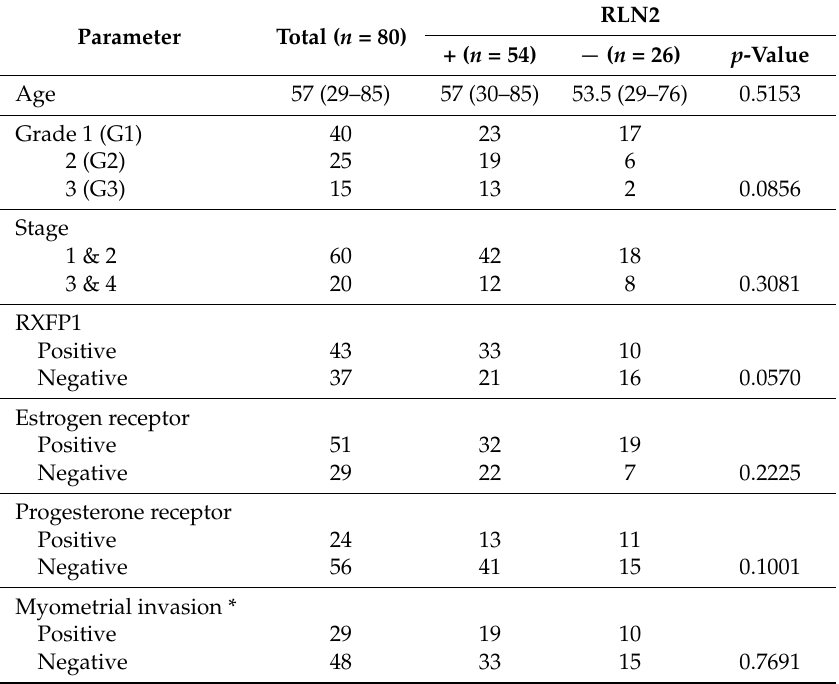
Figure 1. Immunohistochemistry for RXFP1 and RLN2 in human endometrial carcinomas. ( A ) RXFP1-high case, ( B ) RLN2-high case, ( C ) RXFP1-low case, and ( D ) RLN2-low case. Scale bar, 100 μm. Table 1. The association between RLN2 status and clinicopathological parameters in 80 endometrial carcinomas.